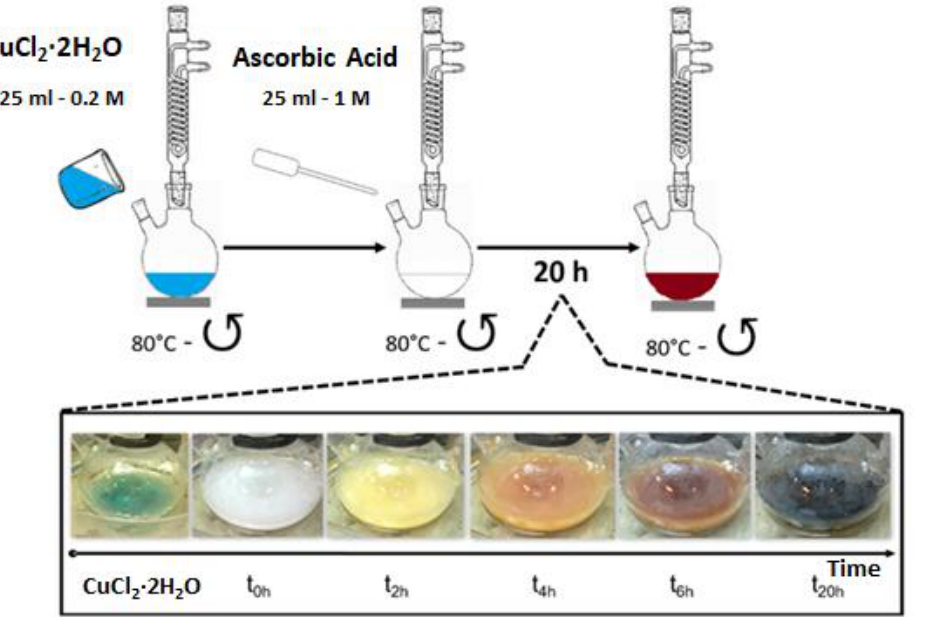
Figure 1. Scheme of the environmentally friendly protocol established to obtain CuNPs using water as solvent and ascorbic acid as mild reducing agent.